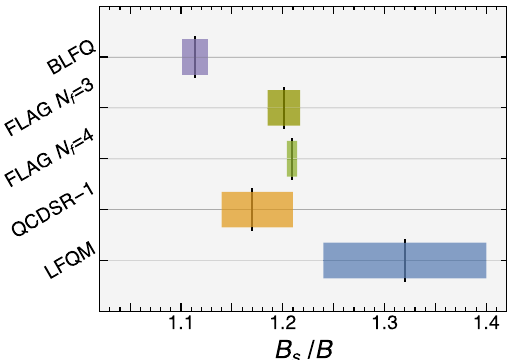
/ f ) and R ( f / f ) withother tical black lines indicate the central value of the ratios, while rectangles D B s B s are the corresponding